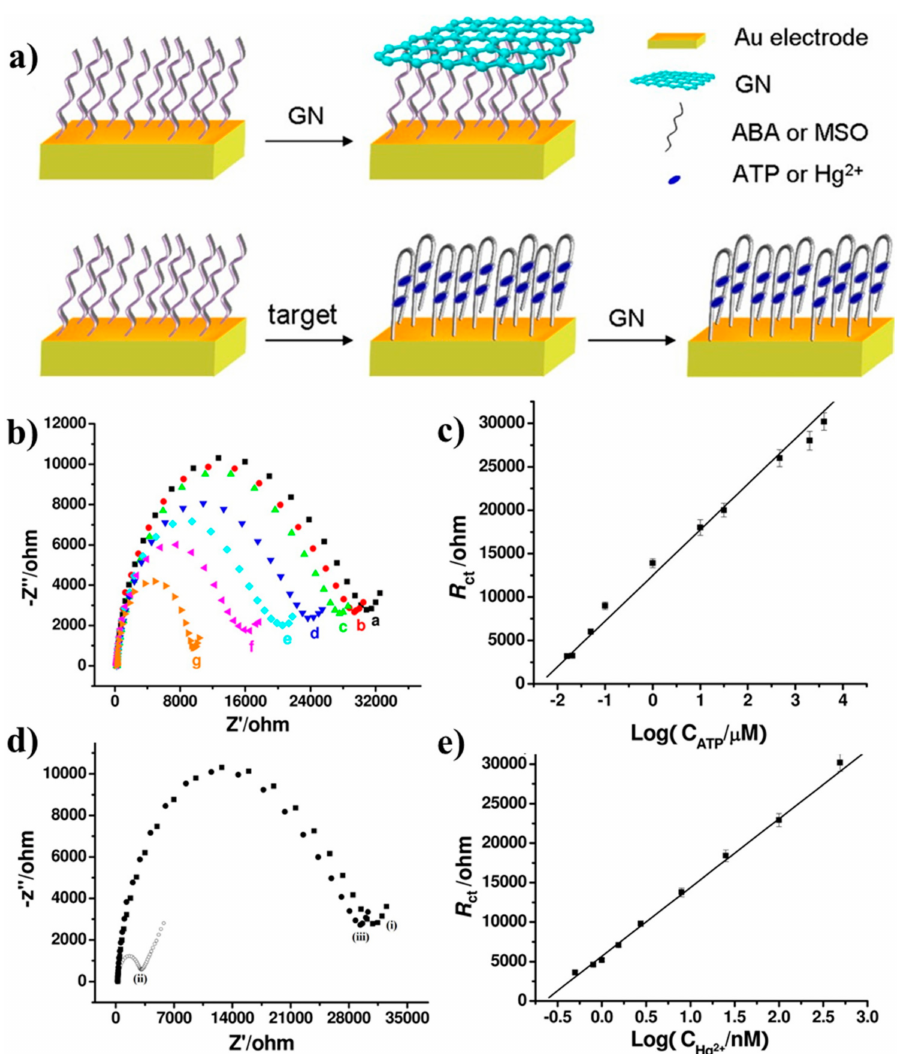
Figure 12. ( a ) Schematics of the sensing platform for the detection of ATP. ( b ) EIS response on the ABA/Au electrode after reacting with different concentrations of ATP (4 mM–0.1 µ M) for 1 h and incubation with 0.3 mg/mL GN. ( c ) The corresponding relationship between R ct and ATP concentration (n = 3). ( d ) EIS response on (i) MSO/Au film, (ii) MSO/Au film incubated with GN, and (iii) MSO/Au reacted with 800 nM Hg 2+ and then incubated with the GN. ( e ) The linear relationship between the EIS and the concentration of Hg 2+ . Reproduced with permission from reference [64]. Copyright © 2020 American Chemical